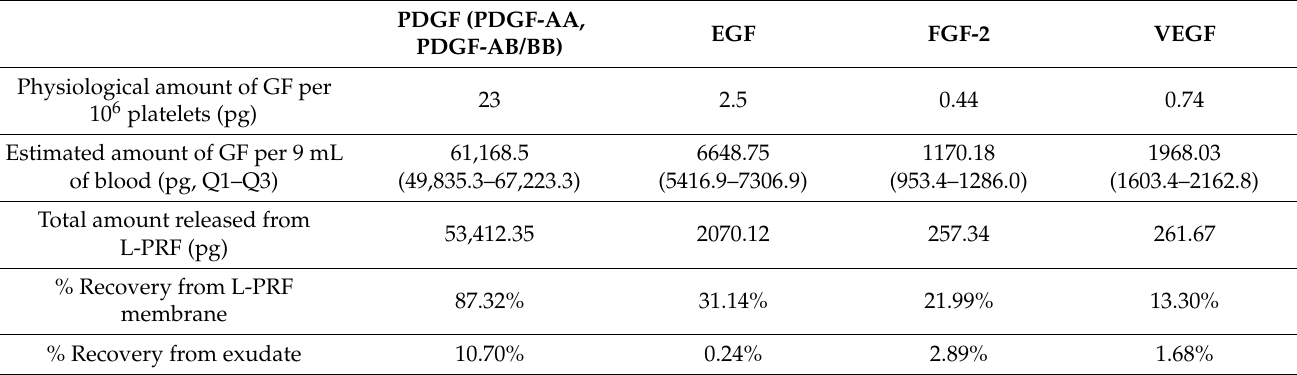
Table 3. GF recovery from L-PRF and